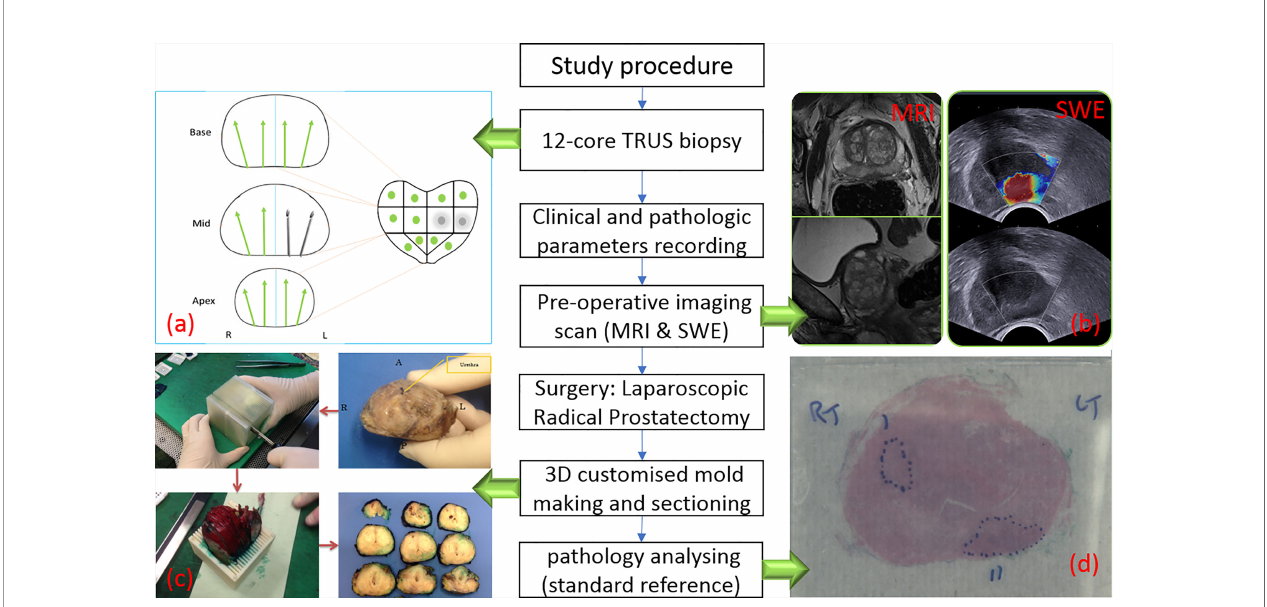
FIGURE 1 | Flow chart of study procedure. (A) TRUS biopsy result with two positive biopsy cores. (B) One suspicious lesion in peripheral zone is shown in MRI (left) and SWE (right) images. (C) Post-prostatectomy specimen sectioning in steps (23). (D) Histopathology photo after